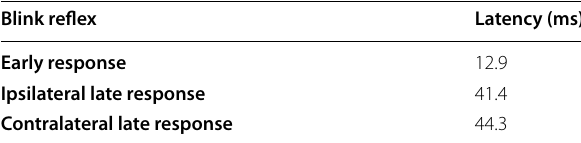
Table 4 Cutoff values of the electrophysiological parameters